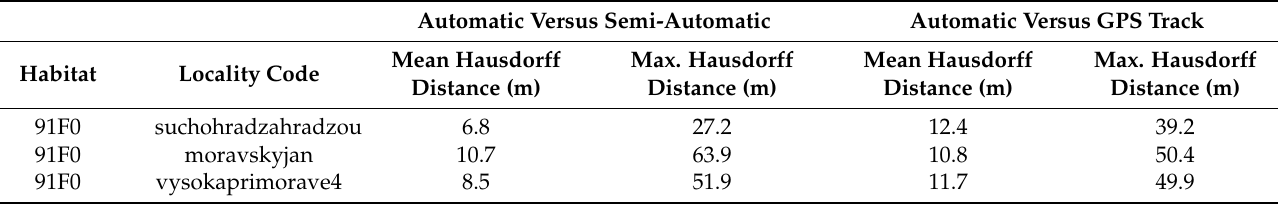
Table 2. Examples of 91F0 habitat localities with the mean and maximal Hausdorff distances of automatically and semi- automatically segmented curves and automatically segmented curves and GPS-tracked